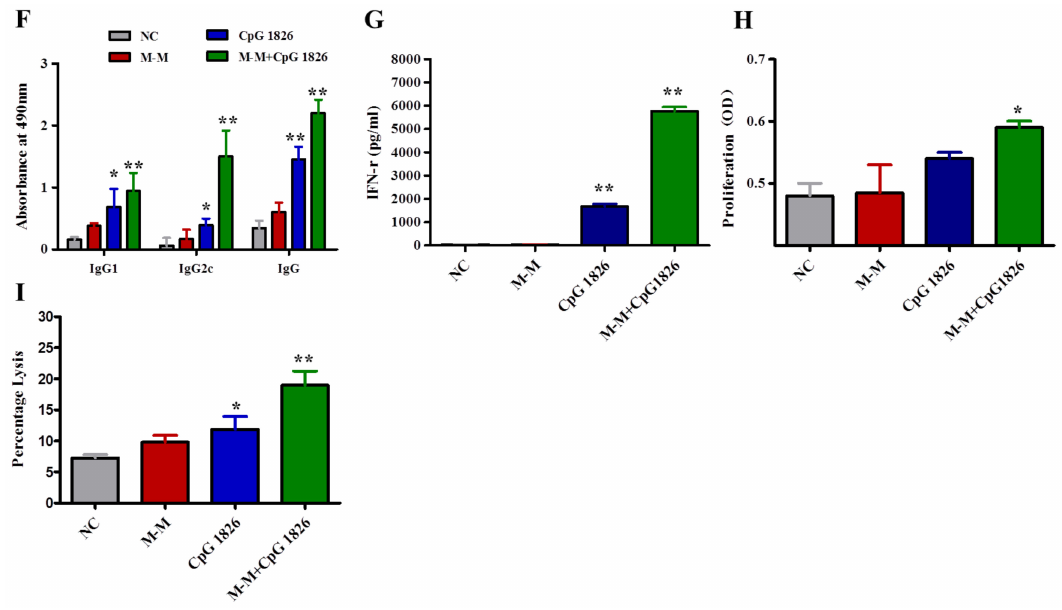
Figure 2. M-M combined with CpG 1826 synergistically enhances the anti-tumor response by inducing MUC1-specific humoral and cellular immune responses. ( A – E ) Four groups of mice ( n = 10) were injected s.c. with PBS, M-M, CpG 1826, or M-M + CpG 1826 on day –21 and –7. On day 0, the sera were collected for the MUC1-specific antibody assay. The splenic mononuclear cells from each group were stimulated in vitro with a specific MUC1 peptide (20 µ g/mL) for five days, and then a cell proliferation assay and cytokine assay were carried out. ( A ) MUC1-specific IgG, IgG1, and IgG2c levels in the sera of the immunized mice were determined by ELISA on day 7 after the last immunization. ( B ) Serum IgG2c/IgG1 ratio. The data represent the mean of ten mice per group. ( C ) The lymphocyte proliferation of the different immunized mice was detected by the WST-1 assay. ( D ) The original image of the chip analysis of the splenocyte cytokine secretion by the Quantibody ® array. Each mouse was replicated four times, and each group consisted of four mice. ( E ) The cytokine secretion detected by Quantibody ® array is expressed as the mean ± standard deviation and is shown in a bar graph. Th1, IFN- γ secreting cells; Th2, IL-4, IL-5, IL-6 IL-13, IL-23 secreting cells; Treg, IL-10, TGF-b1; Th17, IL-17, IL-17F secreting cells. The data represent the mean of four mice per group. * p < 0.05, ** p < 0.01 vs. NC group. ( F – H ) Four group of mice ( n = 10) were injected s.c. with PBS, M-M, CpG 1826 or M-M + CpG 1826 on day –21 and –7. On day 0, a tumor challenge was performed with subcutaneous injection of 5 × 10 5 B16- MUC1 cells. On day 14, the sera were collected for the MUC1-specific antibody assay. The splenic mononuclear cells from each group were stimulated in vitro with a specific MUC1 peptide (20 µ g/mL) for five days, and then a cell proliferation assay, cytokine assay were carried out. ( F ) MUC1-specific IgG, IgG1 and IgG2c levels in the sera of the immunized mice were determined. ( G ) The IFN- γ secretion is detected by ELISA ( H ) lymphocyte proliferation of the different immunized mice was detected by the WST-1 assay. ( I ) Effects of M-M combined with CpG 1826 on MUC1-specific CTL killing activity. Four groups of mice ( n = 10) were injected s.c. with PBS, M-M, CpG 1826, or M-M + CpG 1826 on day –21 and –7. On day 0 splenic mononuclear cells were isolated. The splenic mononuclear cells from each group were stimulated in vitro with a specific MUC1 peptide (20 µ g/mL) for five days, and then CTL cytotoxicity assay was carried out. Statistical significance compared with other groups was represented as follows: * p < 0.05, ** p < 0.01 vs. the NC